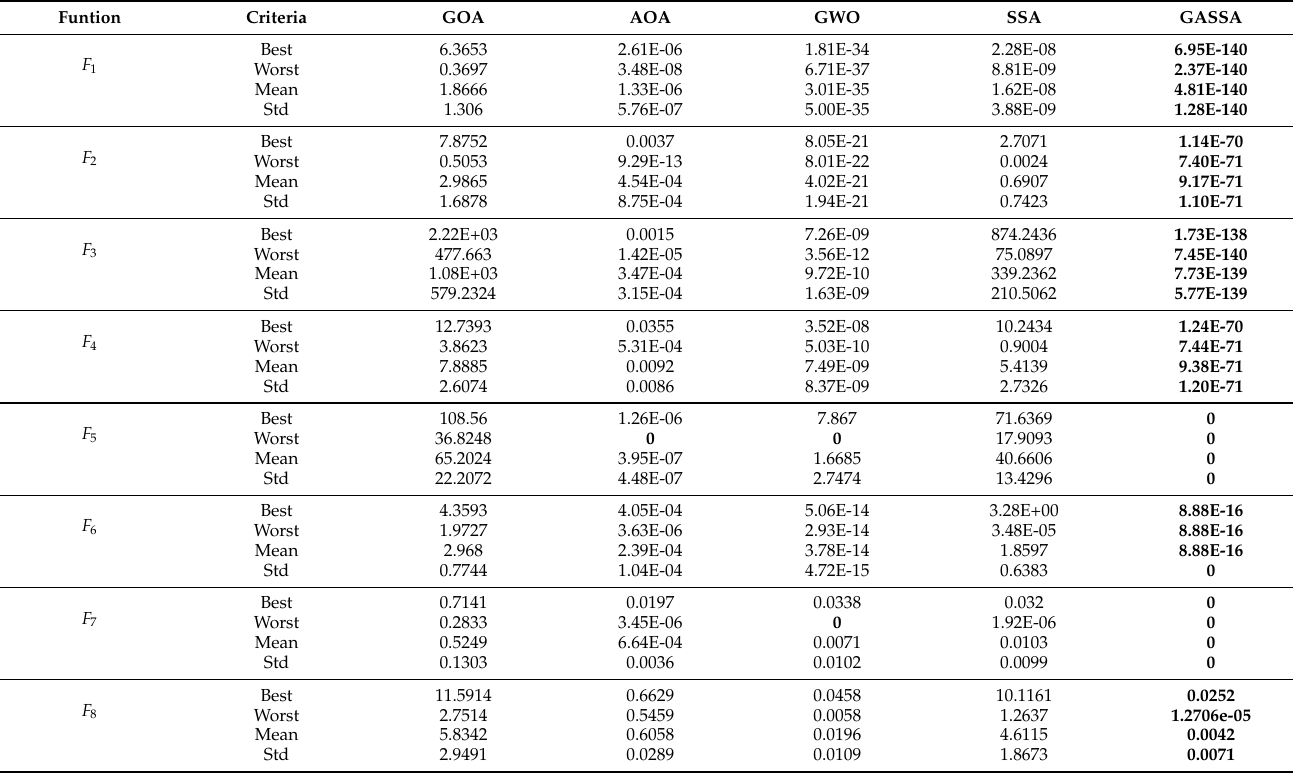
Table 2. Results of benchmark test functions.